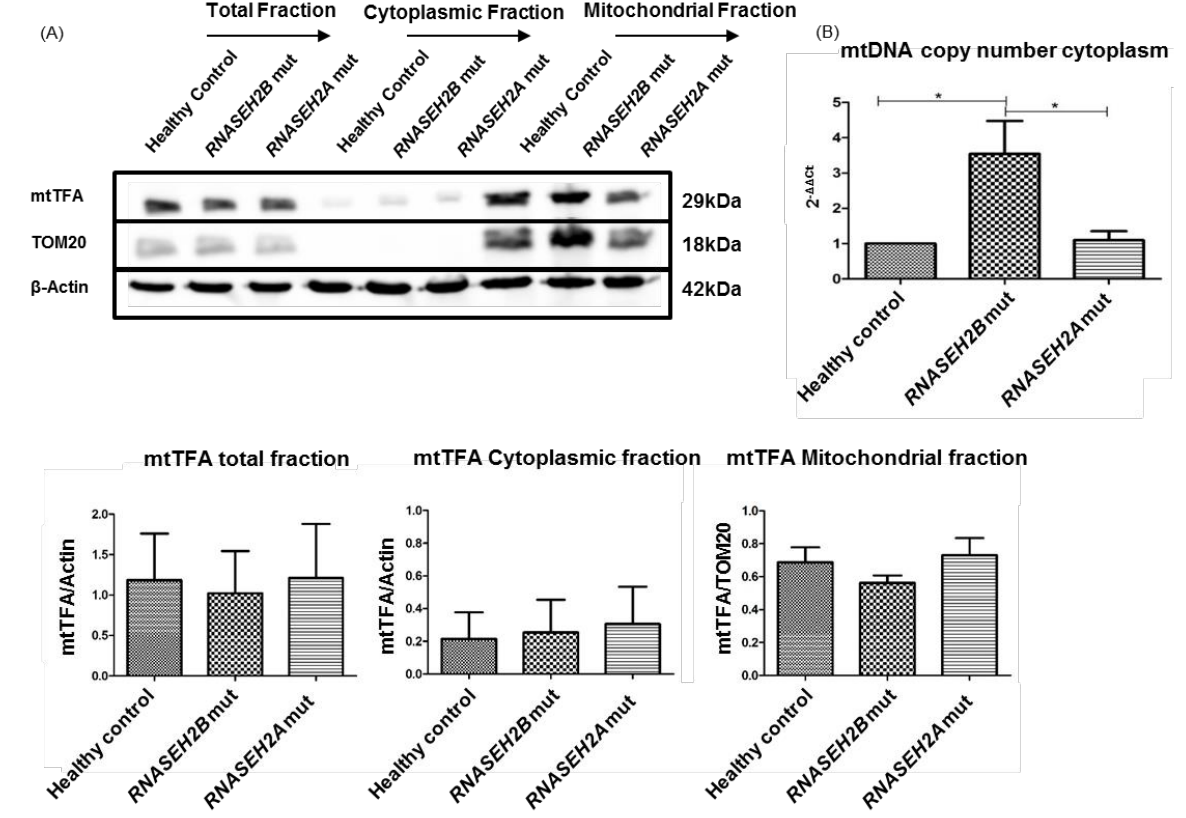
Figure 4. Correlation between mtTFA protein level and mtDNA release from altered mitochondria in RNASEH2B - and RNASEH2A -mutated LCLs. ( A ) Representative Western blot and histogram of the mtTFA protein level in LCLs derived from healthy control and AGS patients. B-Actin was used to normalize the total and the isolated cytoplasmic fraction and TOM20 was used to normalize the isolated mitochondrial fraction of the proteins. ( B ) Expression of mitochondrial MT-TL1 in healthy control and AGS patients ( RNASEH2B - and RNASEH2A -mutated). B2M was used to normalize the gene expression. The bar graph represents the mean of three biological experiments. ANOVA test and post hoc analysis Tukey’s Test have been performed. * p <